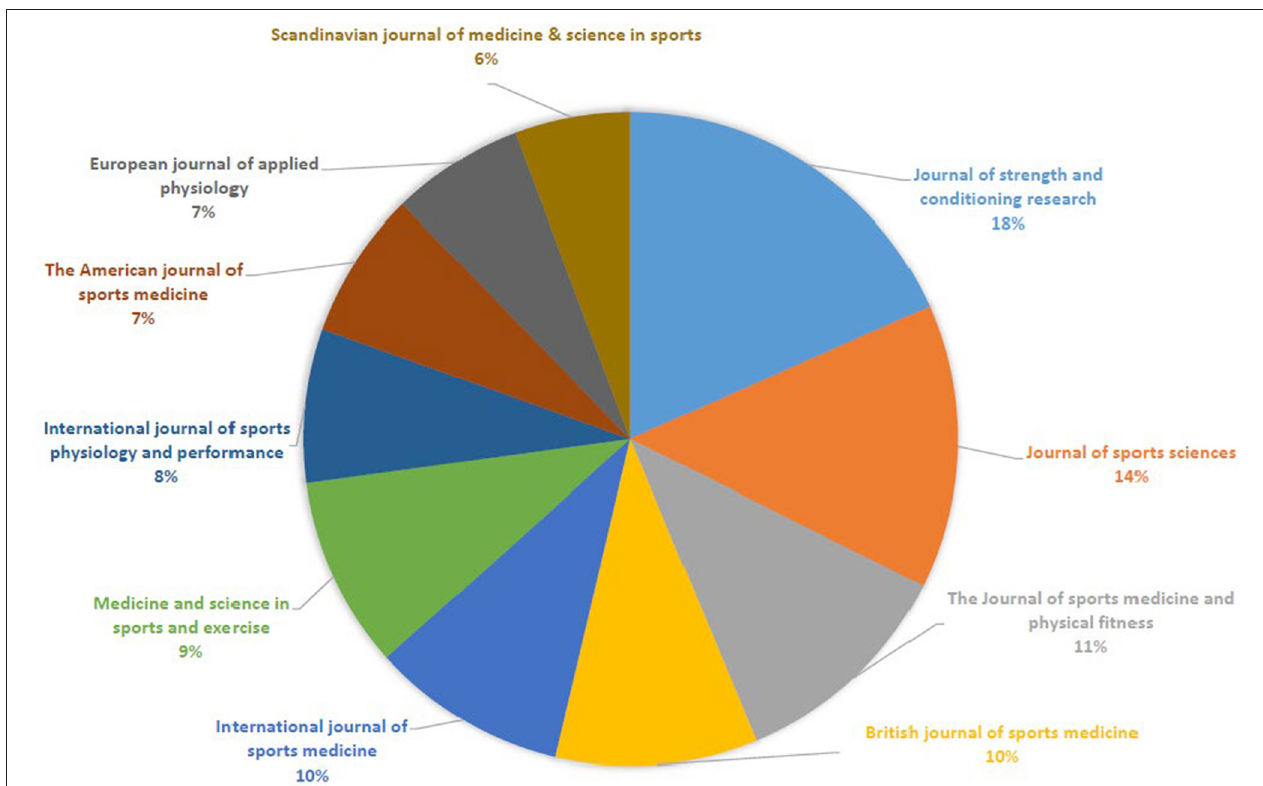
FIGURE 5 | Distribution of major “Olympic sports science” publications across journals for all Olympic